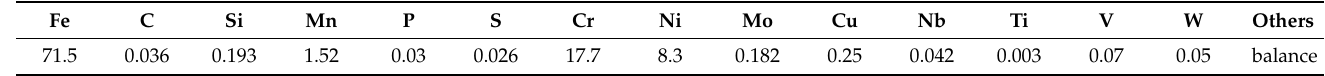
Table 1. Chemical composition in weight percentages (wt%) of the tested AISI 304 steel.